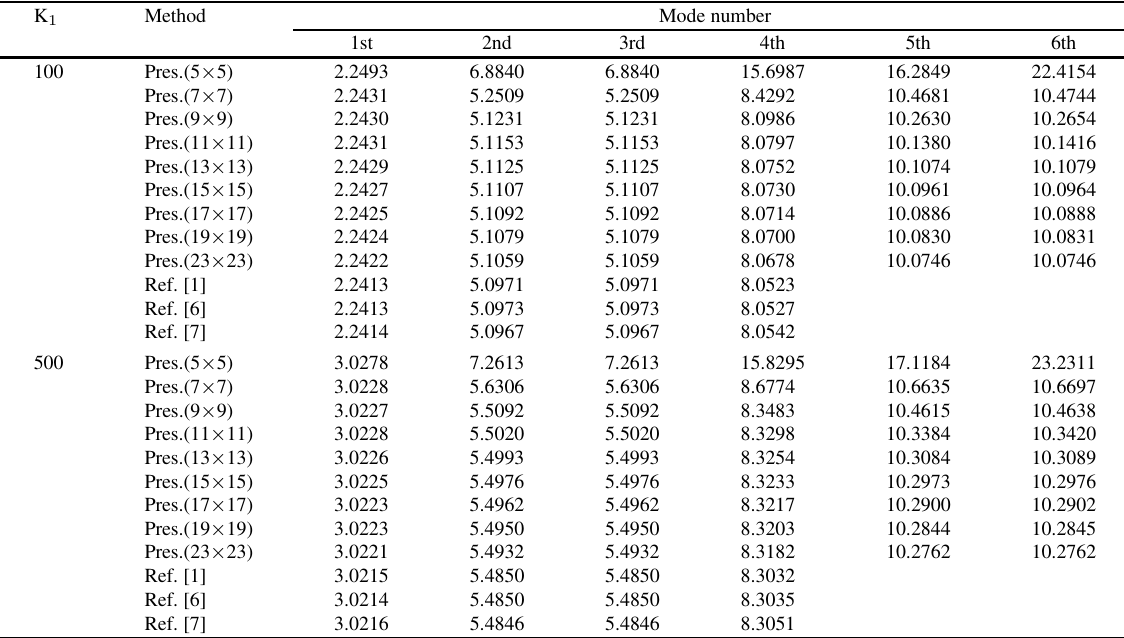
(cid:2) 2 ρh D , of a square SSSS plate resting on Winkler’s type elastic π 2